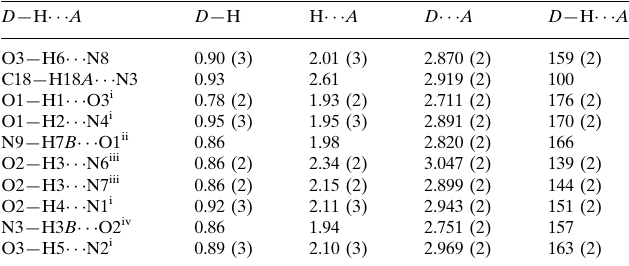
Hydrogen-bond geometry (A˚ , (cid:2)